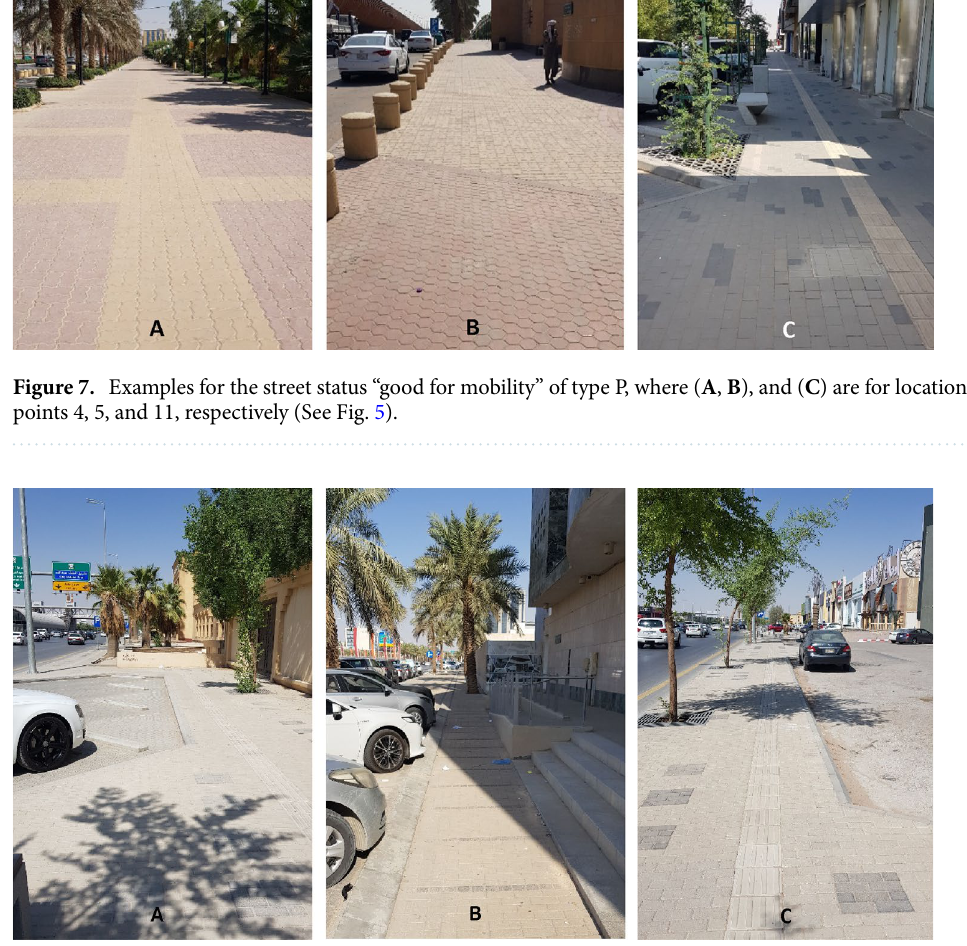
Figure 8. Examples for the street status “Passable for mobility but requires minor attention” of type P, where ( A , B , C ) are for location points 1, 6, and 20, respectively (See Fig.